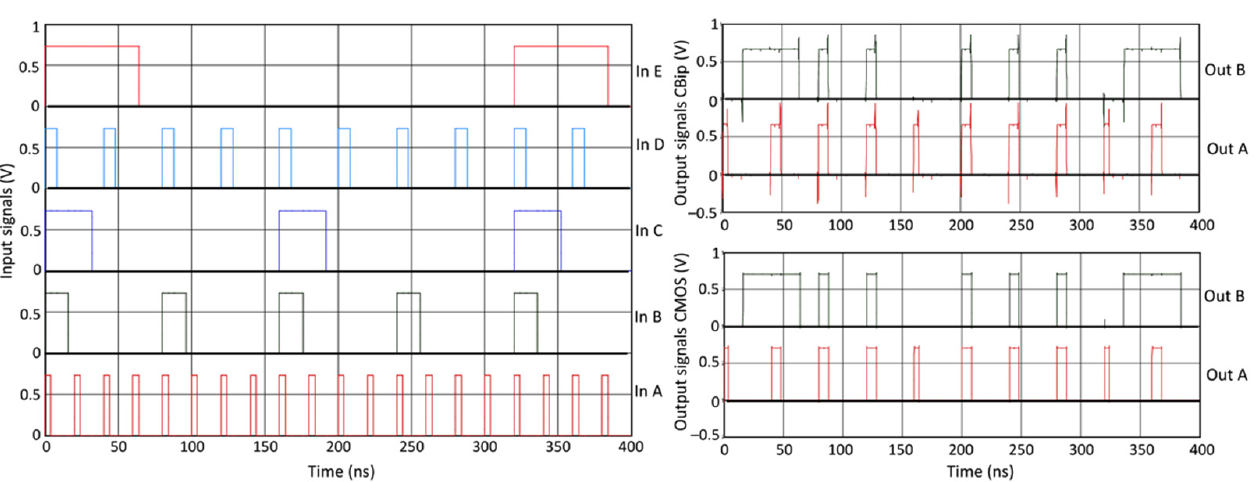
Figure 19. Simulated operation of the ISCAS C17 benchmark: CBip and 22 nm CMOS implementation. CBip: V CC = 1 V, R = 3 M Ω . CMOS: V DD = 0.7 V. Temperature 300 K in both cases.